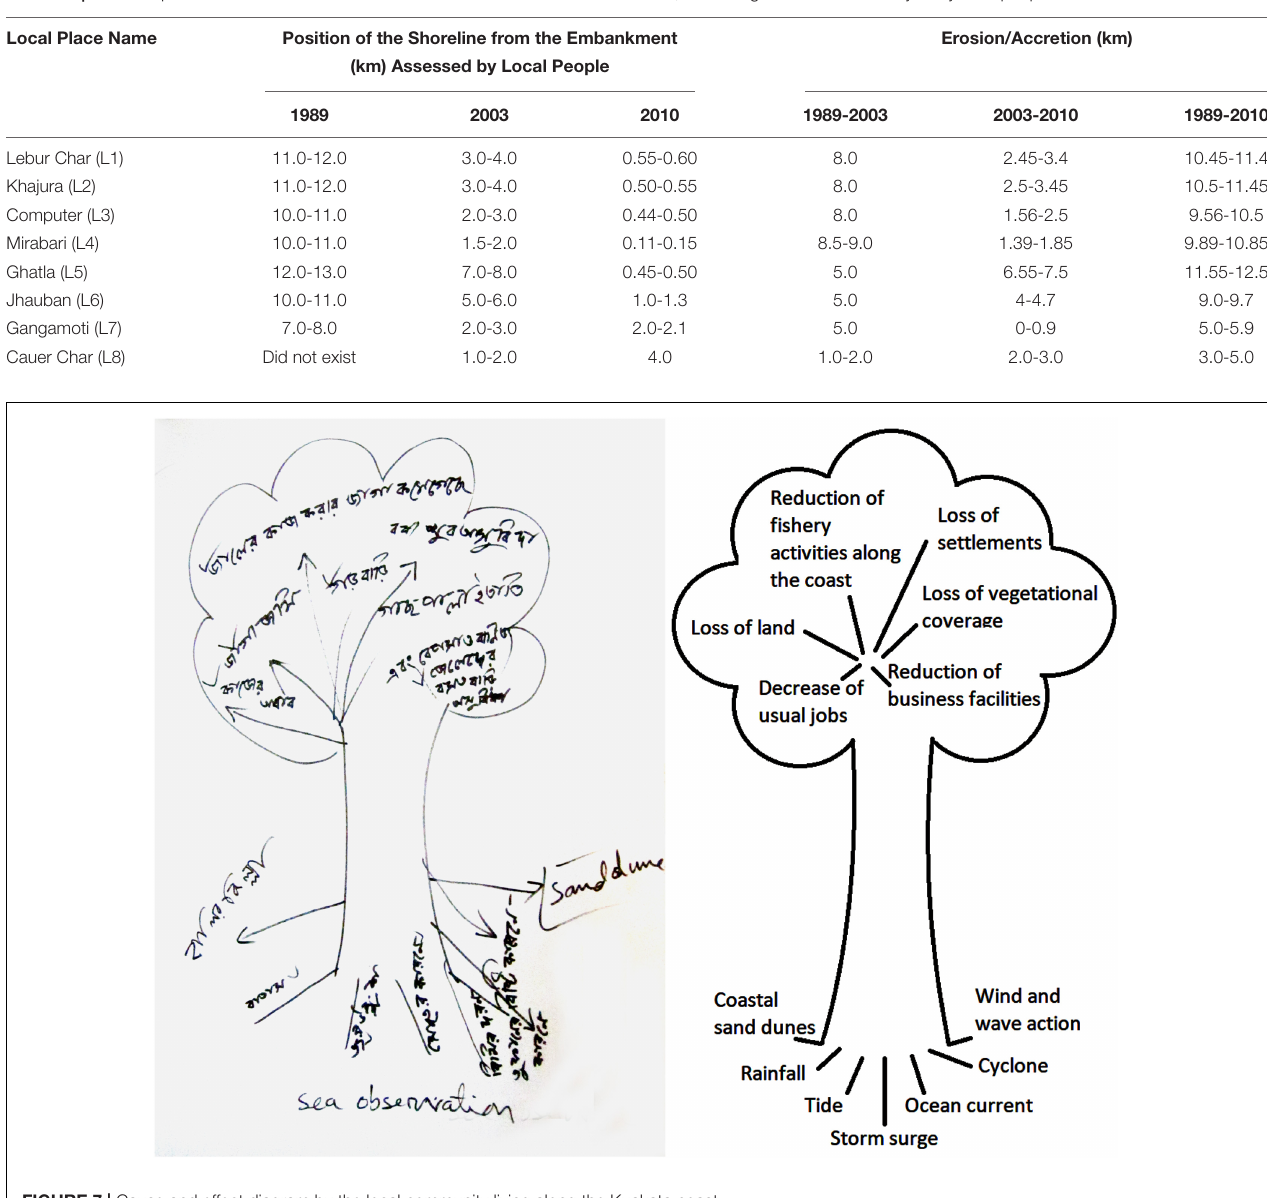
FIGURE 7 | Cause and effect diagram by the local community living along the Kuakata